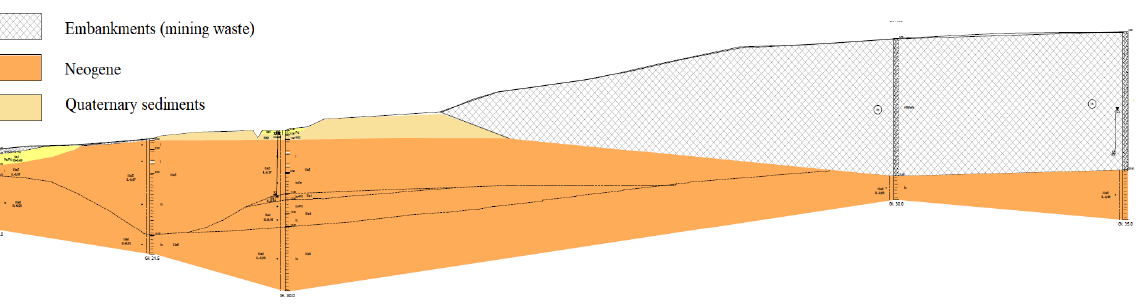
Figure 4. Overburden profile of the studied site at the Janina mine waste dump [38].